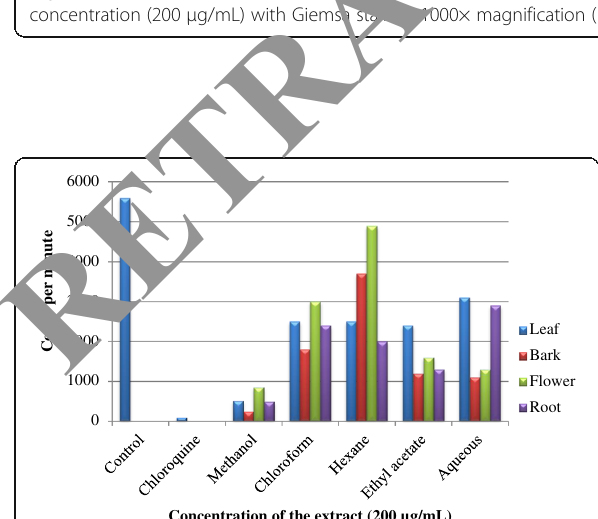
Fig. 4 Counts per minute (CPM) of untreated (control) and treated groups against P. falciparum 3D7